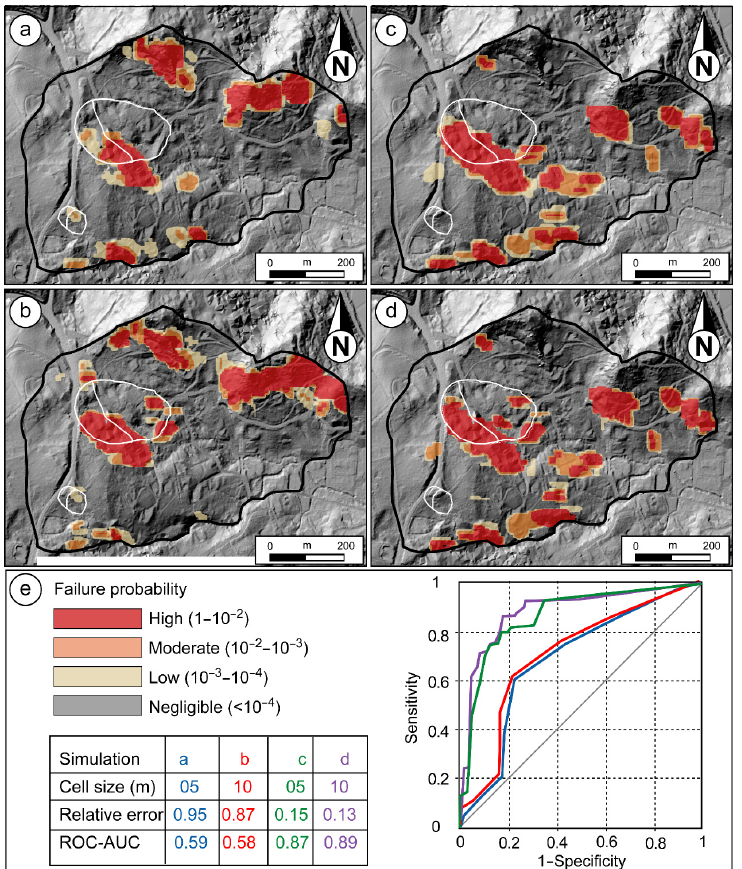
Figure 12. Comparison of results with cell sizes of 5 m and 10 m for the Morne-Figue area. ( a ) Map computed for shallow translational landslides with a cell size of 10 m. ( b ) Map computed for shallow translational landslides with a cell size of 5 m. ( c ) Map computed for moderately deep rotational landslides with a cell size of 10 m. ( d ) Map computed for moder- ately deep rotational landslides with a cell size of 5 m. ( e ) Statistical tests for the four computed maps. For each map the GWL = 1. Hillshade maps were produced with the Litto3D DTM (IGN, 2010). For both cases, the results few differ between computations with a cell size of 5 m or 10 m, either statistically or visually on the computed maps. Thus, for the two sites, a cell size of 10 m appears to be the best compromise for the next phase. For the Morne-Figue site, given the low representativeness of the models, it is necessary to have other infor- mation to better adjust the computations. Therefore, the influence of the GWL is not tested for shallow translational landslides.